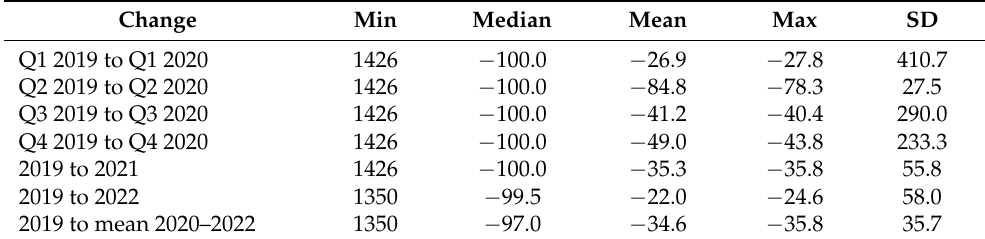
Table 6. Descriptive statistics of dependent variables (change in